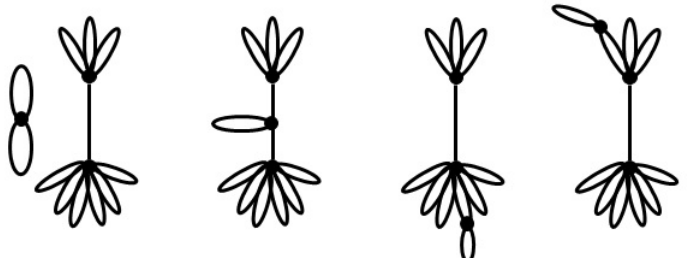
Figure 9 One disconnected and three connected graphs with degree sequence